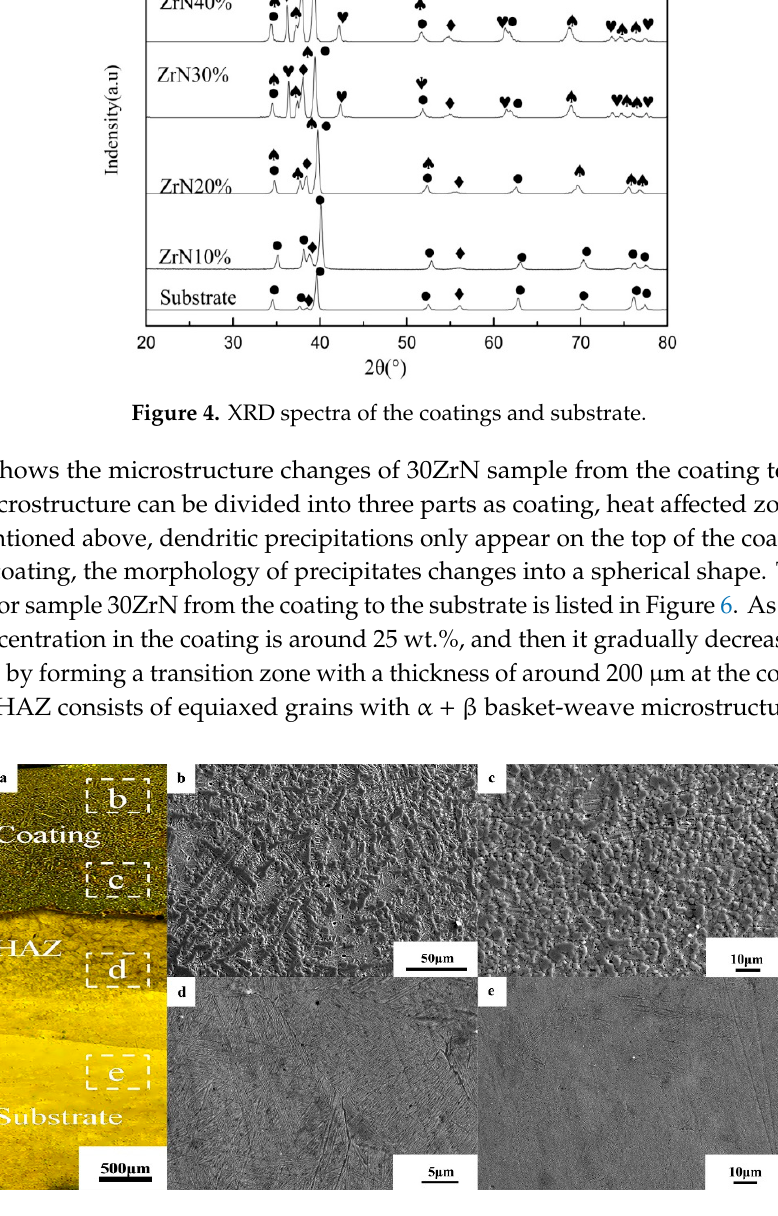
image of ( b ) the top of the coating, ( c ) the bottom of the coating, ( d ) heat affected zone (HAZ), and ( e )